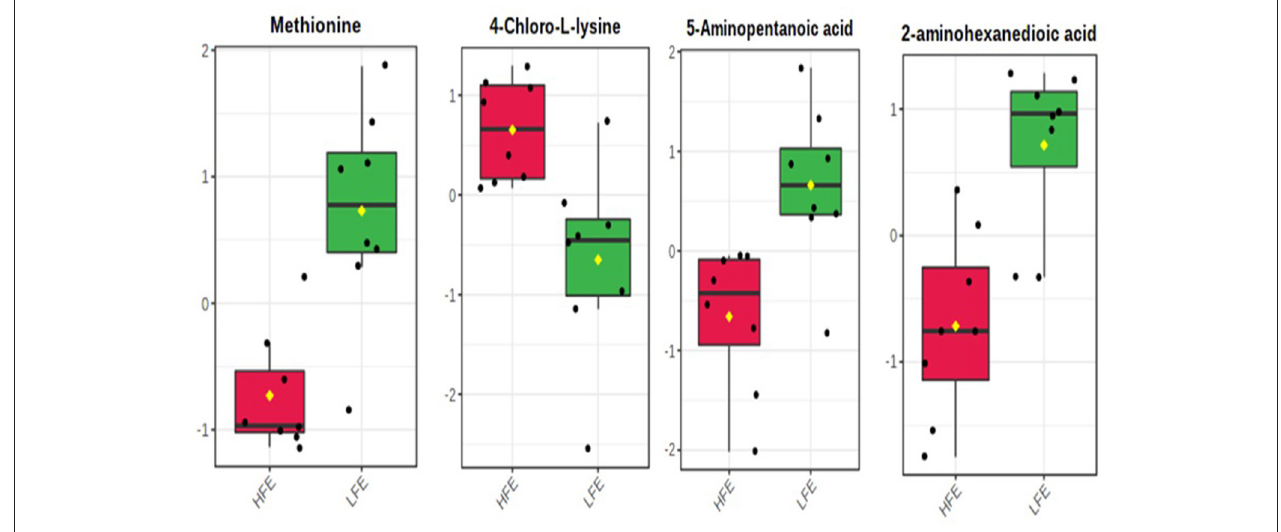
FIGURE 4 | Relative distributions of the candidate plasma amine/phenol biomarkers of beef steer with divergent RFI values. HFE, beef steers with negative residual feed intake; LFE, beef steers with positive residual feed intake.